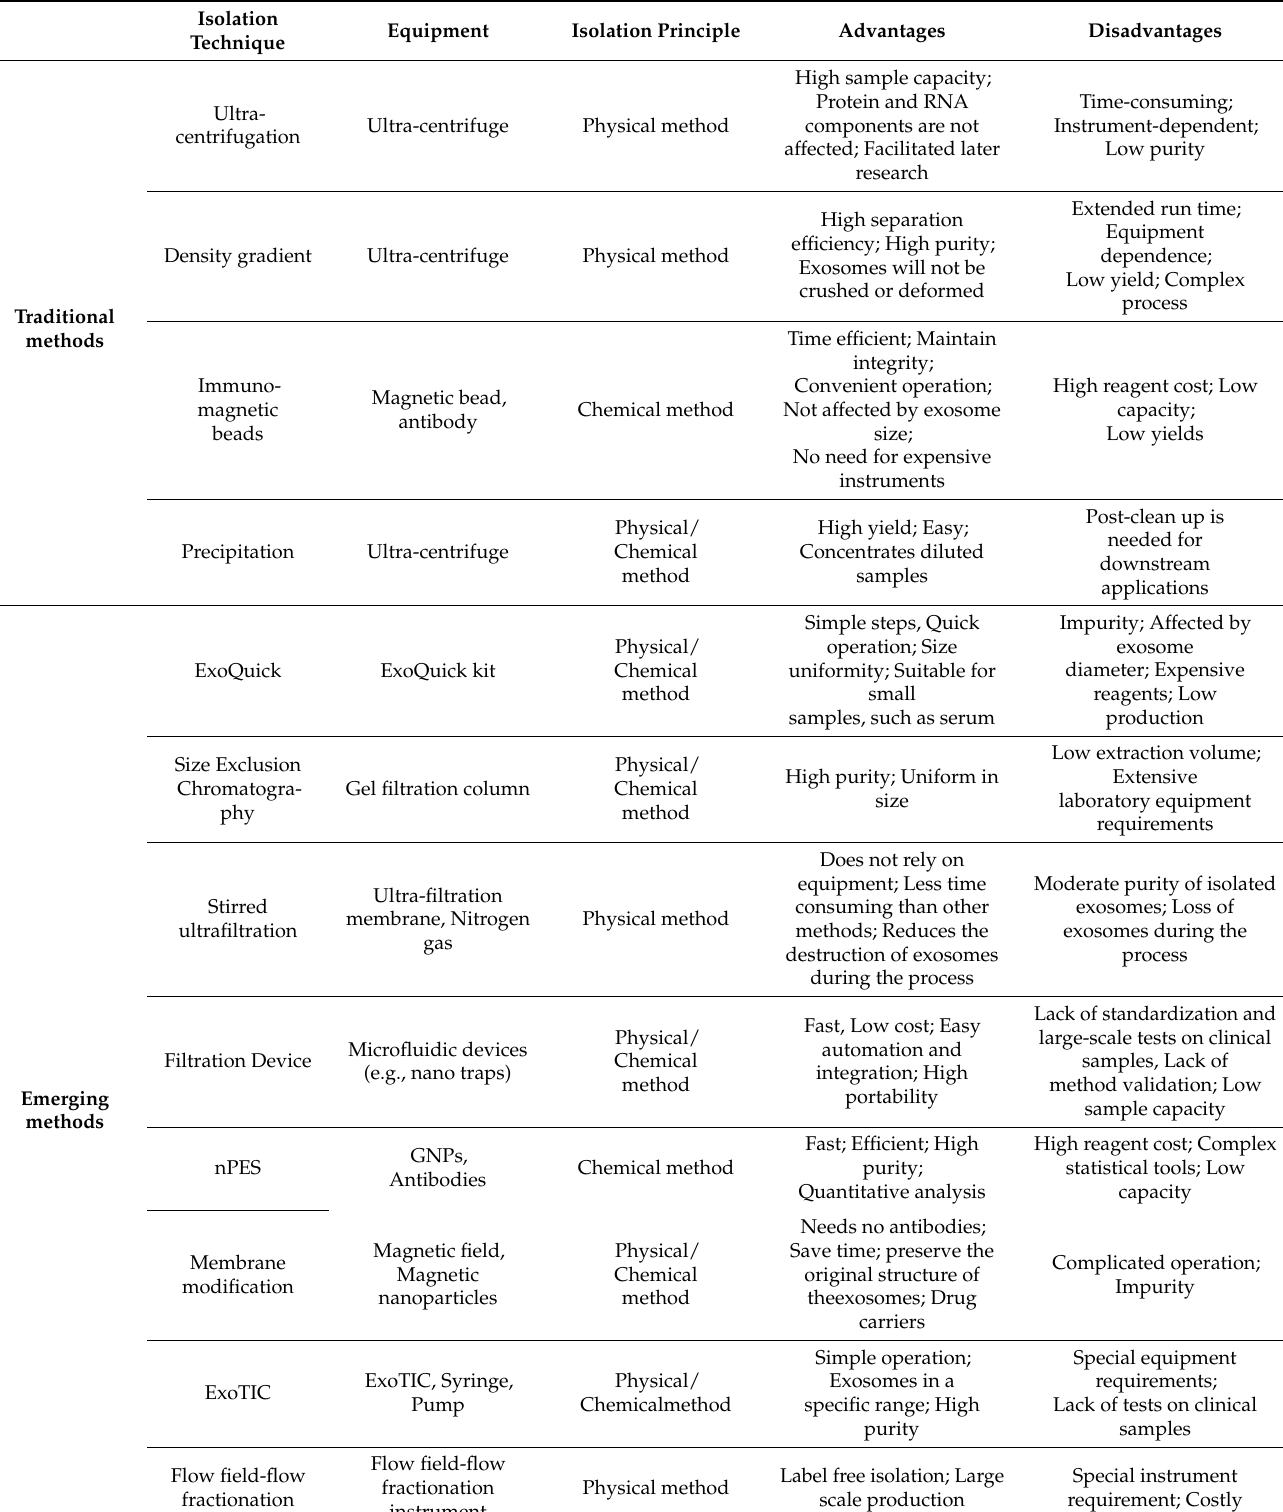
(Table 5). Still, due to overlapping size range, small sizes, and similar morphologies to other extracellular vesicles challenges persist in isolation methods. Table 5. Characteristics of exosome isolation methods